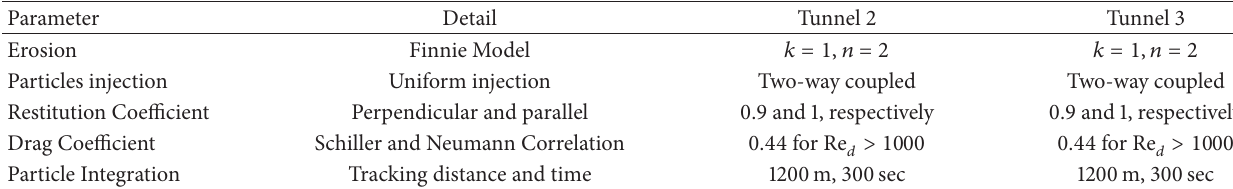
Table 5: Various constants and coefficients used in simulation.